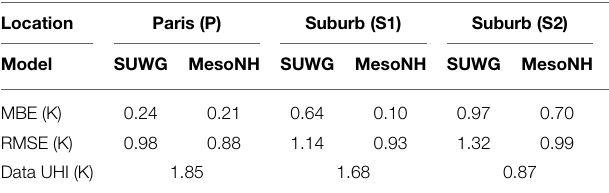
TABLE 3 | Comparison of the scores of the nighttime urban heat island at 2m in Paris and its suburbs given by the models (MesoNH and